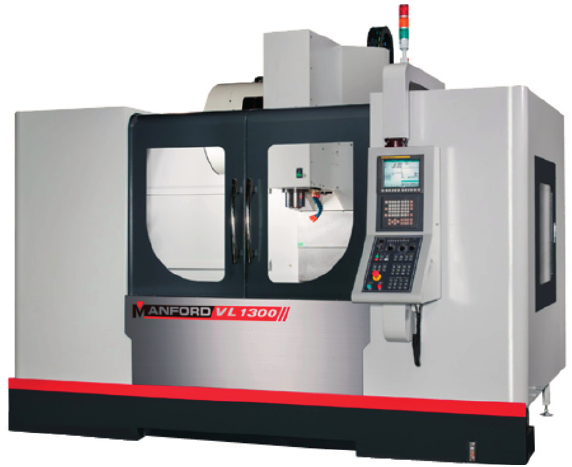
Figure 5. New innovative design shape for the machine tools.